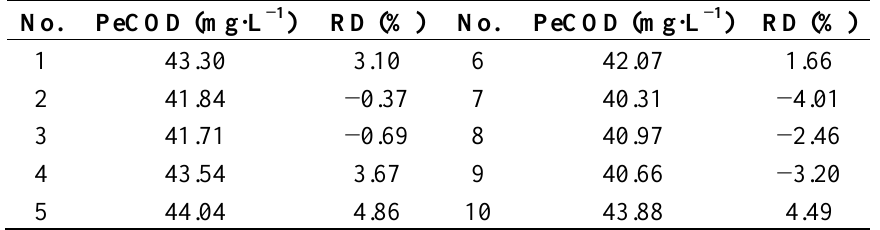
Table 1. Comparison of ThCOD and the PeCOD obtained by proposed method.